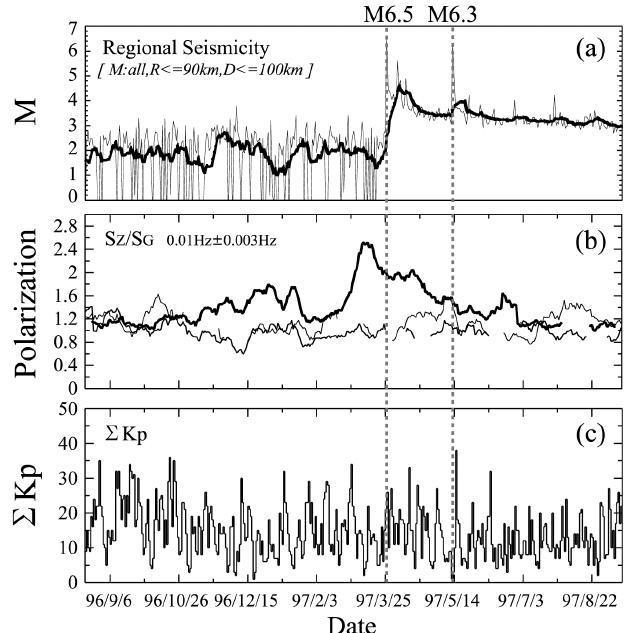
Figure 4. Polarization results at Tarumizu, Chichijima and Darwin. (a) Temporal evolution of regional seismicity, (b) temporal variation of polarization (S /S , 0.01Hz) at Chichijima and Darwin (thin lines) Z G and at Tarumizu (thick line), and (c) Σ Kp